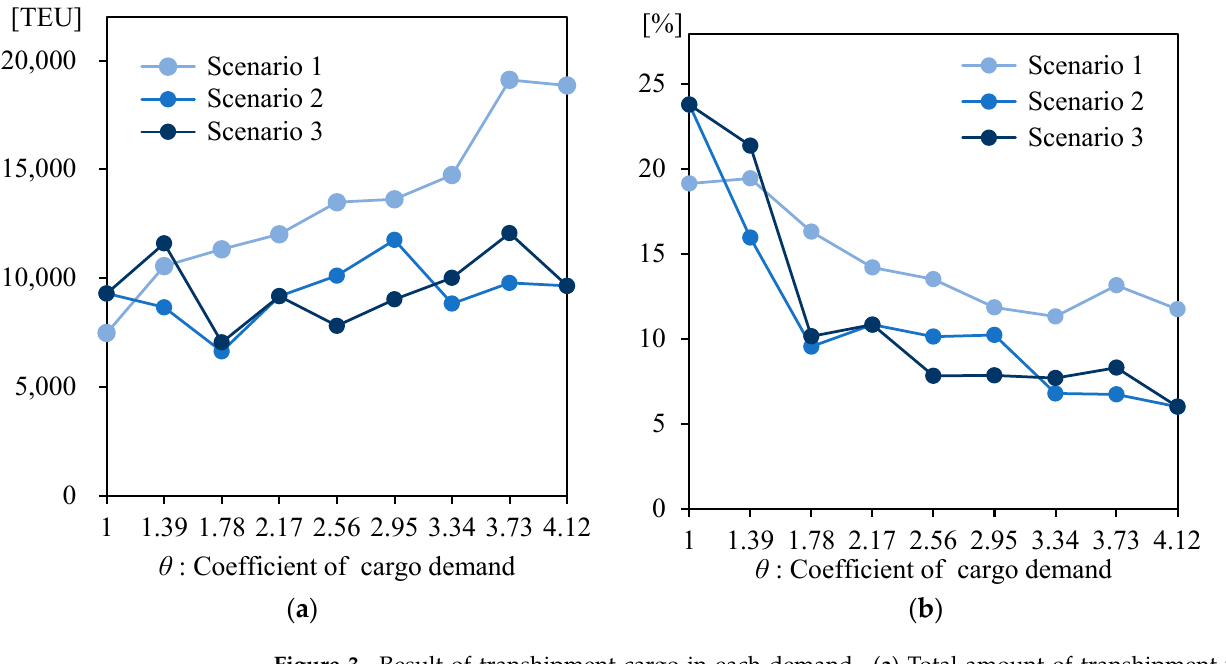
Figure 3. Result of transhipment cargo in each demand. ( a ) Total amount of transhipment via Colombo. ( b ) Ratio of transhipment cargo in Colombo.